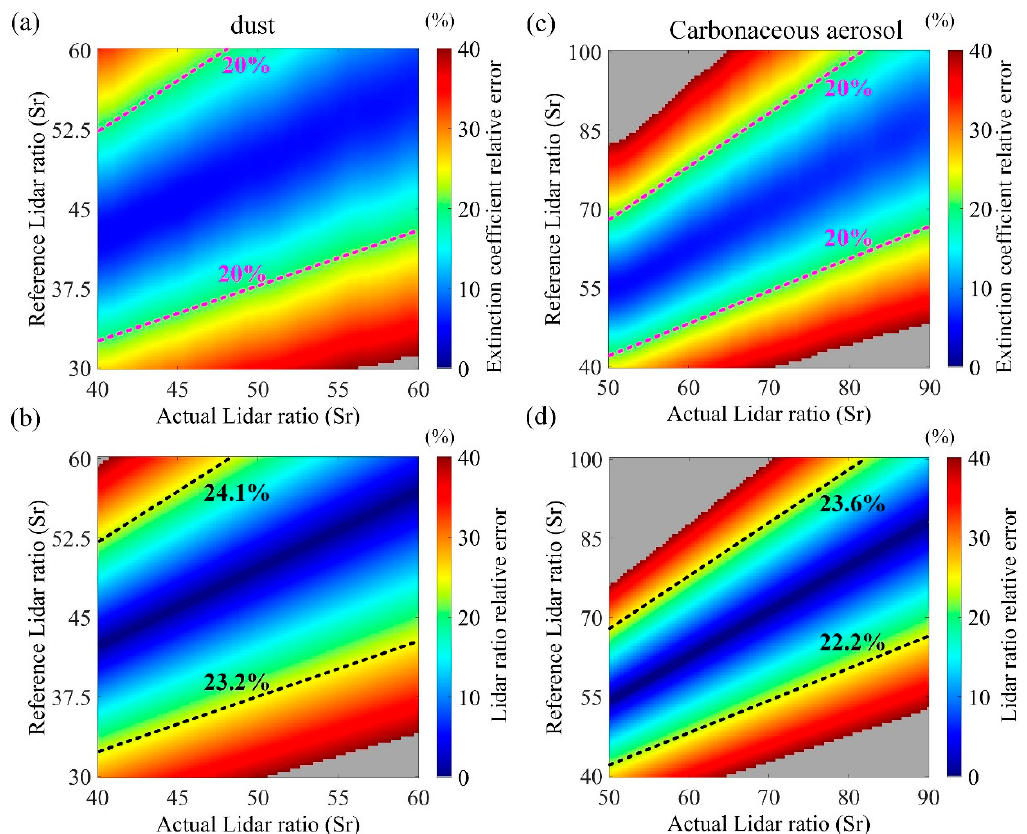
Figure 9. The relationship between the relative error of α a and the lidar ratio, as well as the actual lidar ratio and the reference lidar ratio. ( a , b ) represent the relative error of α a and the lidar ratio under the dust condition; ( c , d ) represent the relative error of α a and the lidar ratio under the carbonaceous aerosol condition. The pink dotted line represents the position where the relative error of α a was 20%, and the black dotted line represents the relative error of the lidar ratio at the same position (same horizontal and vertical coordinates) as the pink dotted line in the figure. The grey area represents the part that exceeded the upper limit of the color bar.